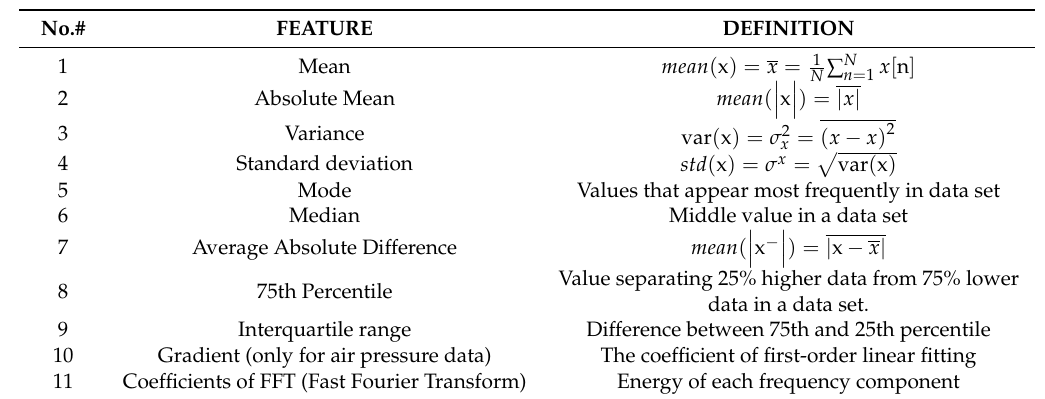
Table 3. Feature set.